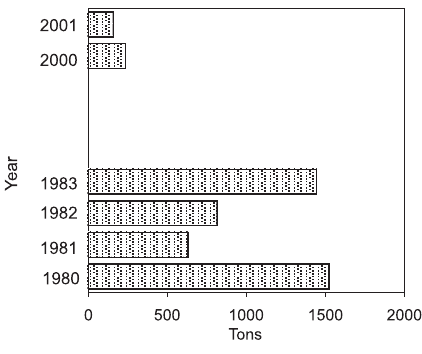
Fig. 7. Total landing of catch in the Cuiabá Fish Market from 1980 to 1983 and current data.